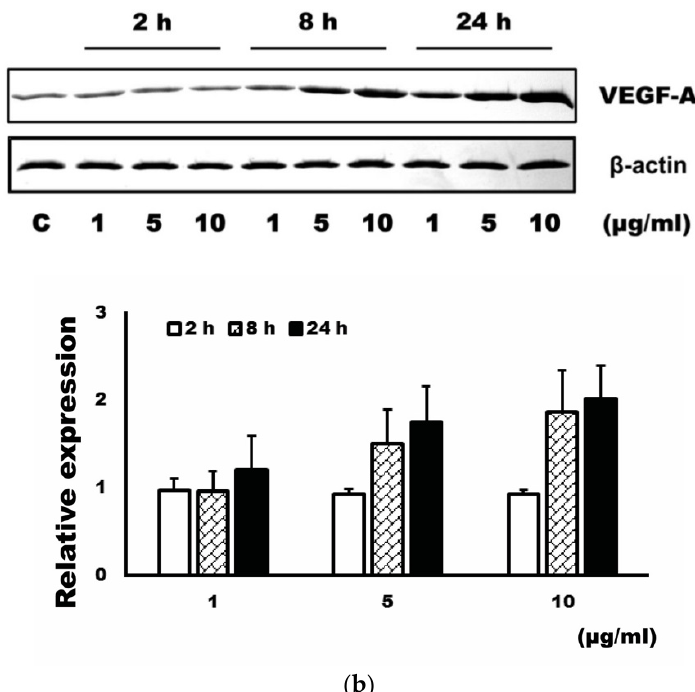
Figure 1. Western blot analysis for 4-hexylresorcinol (4-HR). The application of 4-HR increased the expression level of vascular endothelial growth factor-A (VEGF-A) in ( a ) RAW264.7, and ( b ) HUVEC cells (C: untreated control).